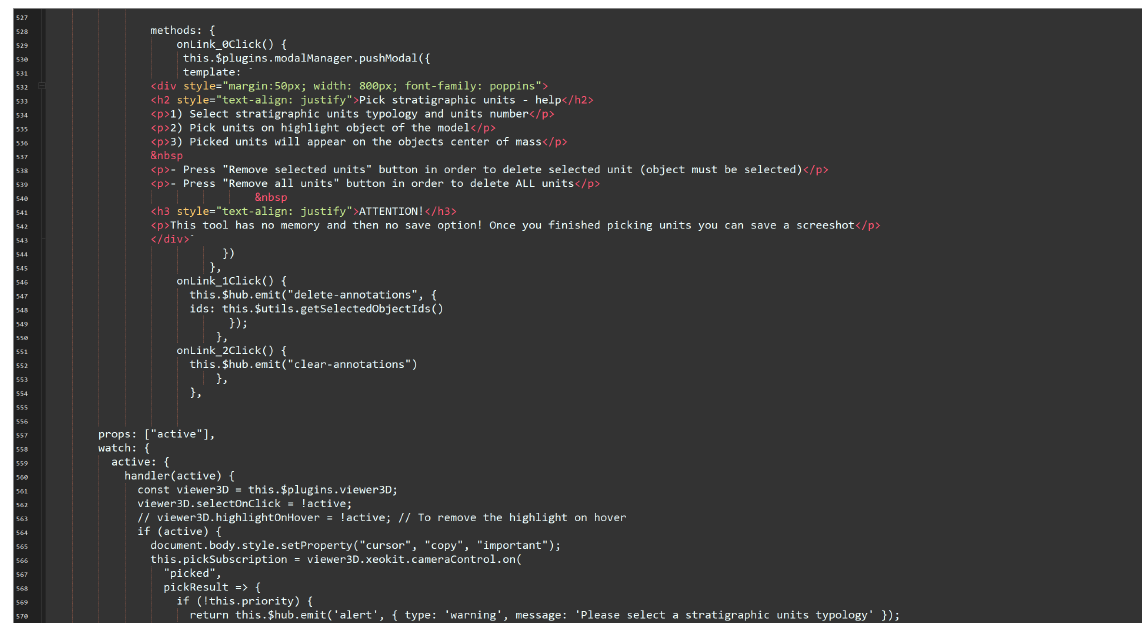
Figure 12. Part of source code related to the Pick Stratigraphic Units plugin (the complete code is on the ARK-BIM website).